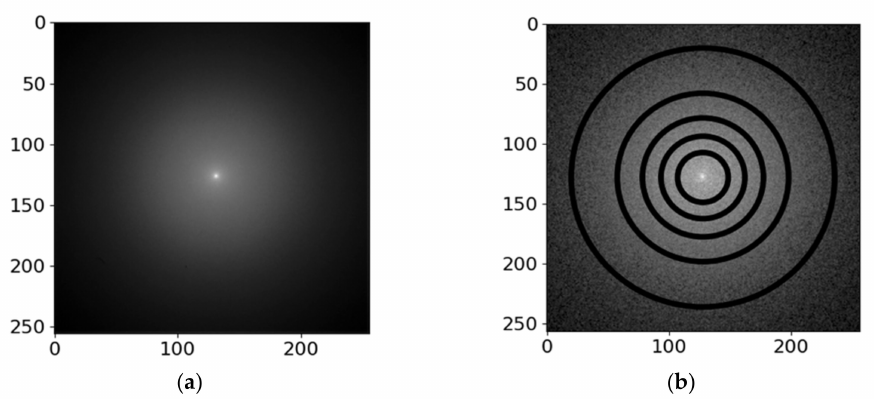
Figure 3. C 100 nm at 15 keV ( a ) 2D-PAD diffractogram, ( b ) simulated distribution of energy dose (glassy-carbon) in the 2D-PAD plane with the appropriately rescaled inactive areas of the segmented STEM detector up to HAADF indicated. The contrast of both data has been enhanced by the gamma correction, value Γ =